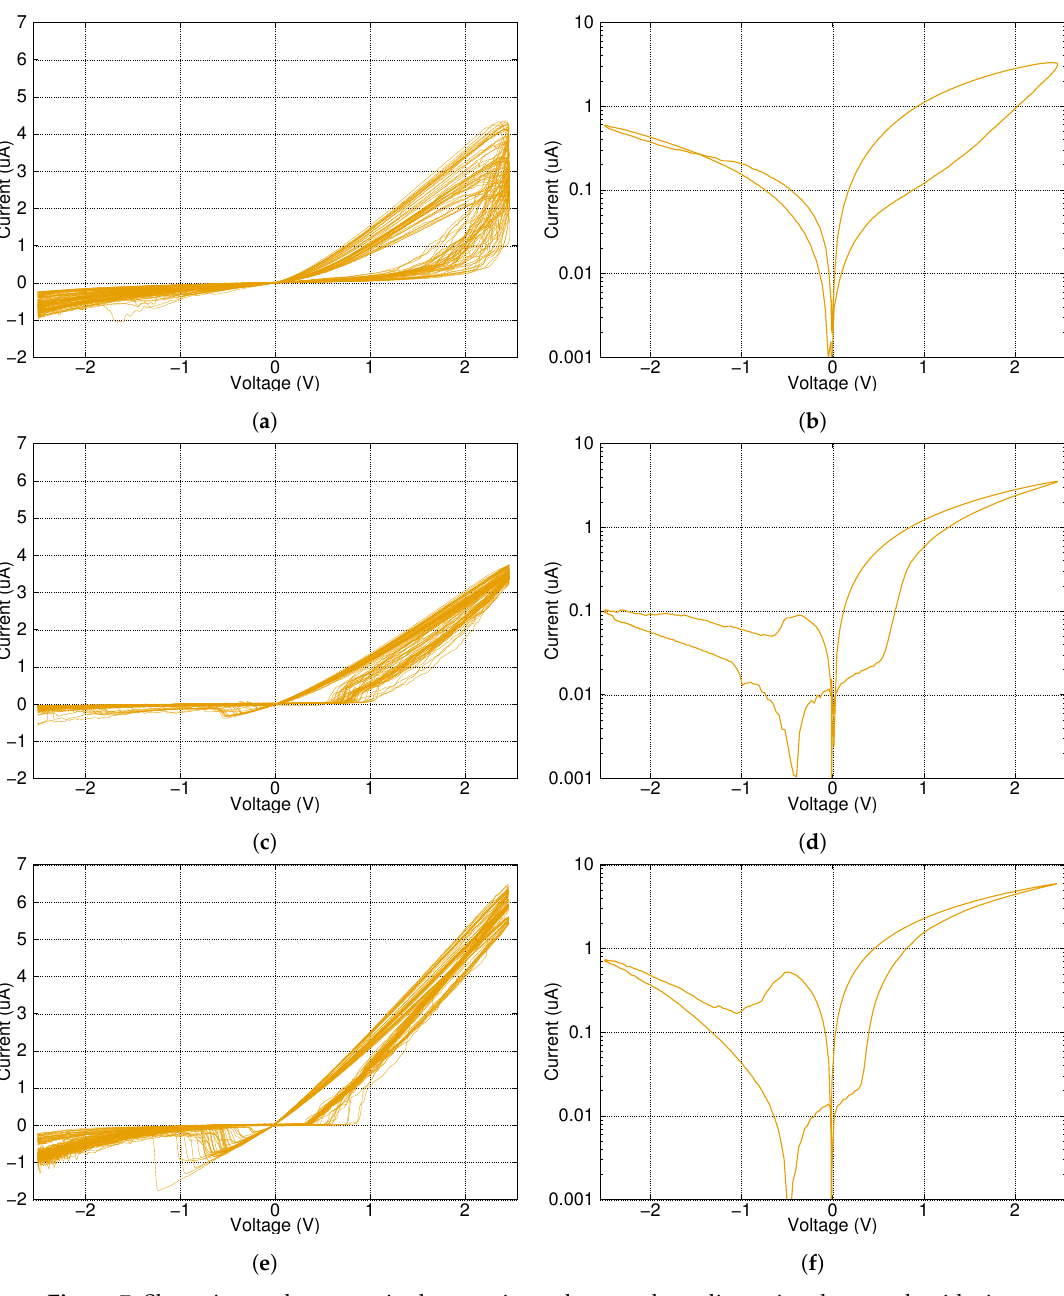
Figure 7. Short-time pulses on a single memristor, the new three dimensional network with sixteen memristors and the reduced network with twelve memristors, respectively. ( a , c ) and ( e ) show the voltage–current diagram of the whole signal. ( b , d ) and ( f ) are the average of all 50 write–erase signals on a logarithmic